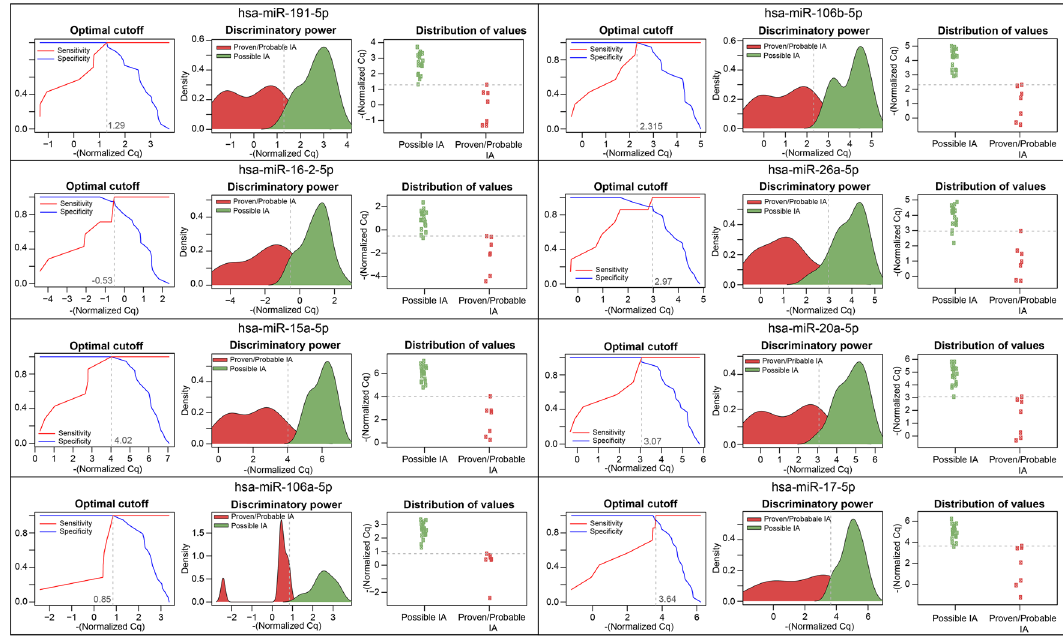
Figure 6. ROC curves were constructed to assess and visualize the performance of 8 preselected miRNAs. To measure the diagnostic accuracy of the miRNAs, relative fold changes were converted to qualitative (proven IA, probable IA vs. possible IA) indexes. The normalized CT values of eight miRNAs revealed their significant downregulation in IA-infected hematology and oncology patients (proven/probable) relative to noninfected patients (possible), indicating IA. Line graphs were used to calculate the optimal cutoff points. Scatter graphs represent the distribution of the CT values in cases and controls, and area plots represent the discriminatory power of the